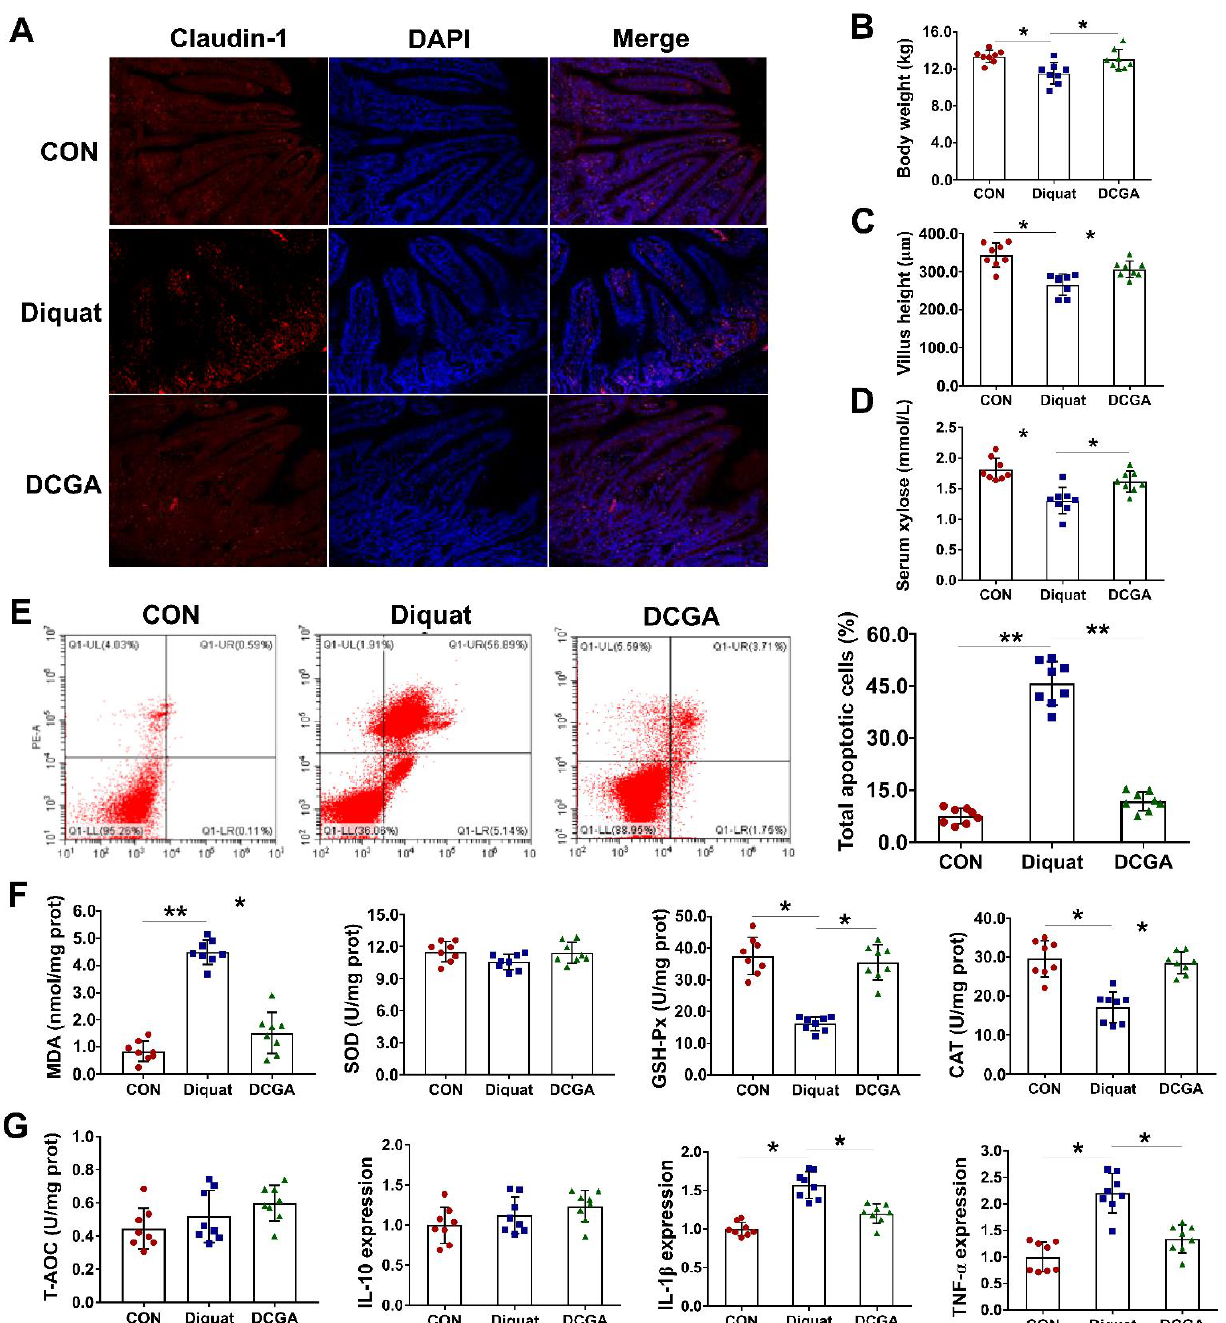
Figure 1. Chlorogenic acid (CGA) attenuates oxidative stress-induced inflammation and intestinal epithelium injury in weaned pigs. ( A ) Localization of the tight-junction protein claudin-1 by immunofluorescence staining. ( B ) Body weight. ( C ) Villus height of the jejunum in weaned pigs upon oxidative stress. ( D ) Serum concentrations of xylose. ( E ) Apoptosis of the intestinal epithelial cells. In each diagram, Q1-UL represents the percentage of nonviable and necrotic cells, Q1-UR represents the percentage of late apoptotic cells, Q1-LR represents the percentages of early apoptotic cells, and Q1-LL represents the percentage of live cells. ( F ) Abundances of malondialdehyde (MDA) and antioxidant enzymes in the intes- tinal mucosa. ( G ) Abundance of total antioxidative capability (T-AOC) and expressions of IL-10, IL-beta and TNF-alpha, respectively, in the intestinal mucosa. CON, pigs fed with basal diet; diquat, pigs fed with basal diet and challenged by diquat; DCGA, pigs fed with basal diet containing 1000 mg/kg CGA and challenged by diquat ( n = 8). * p < 0.05, ** p < 0.01.